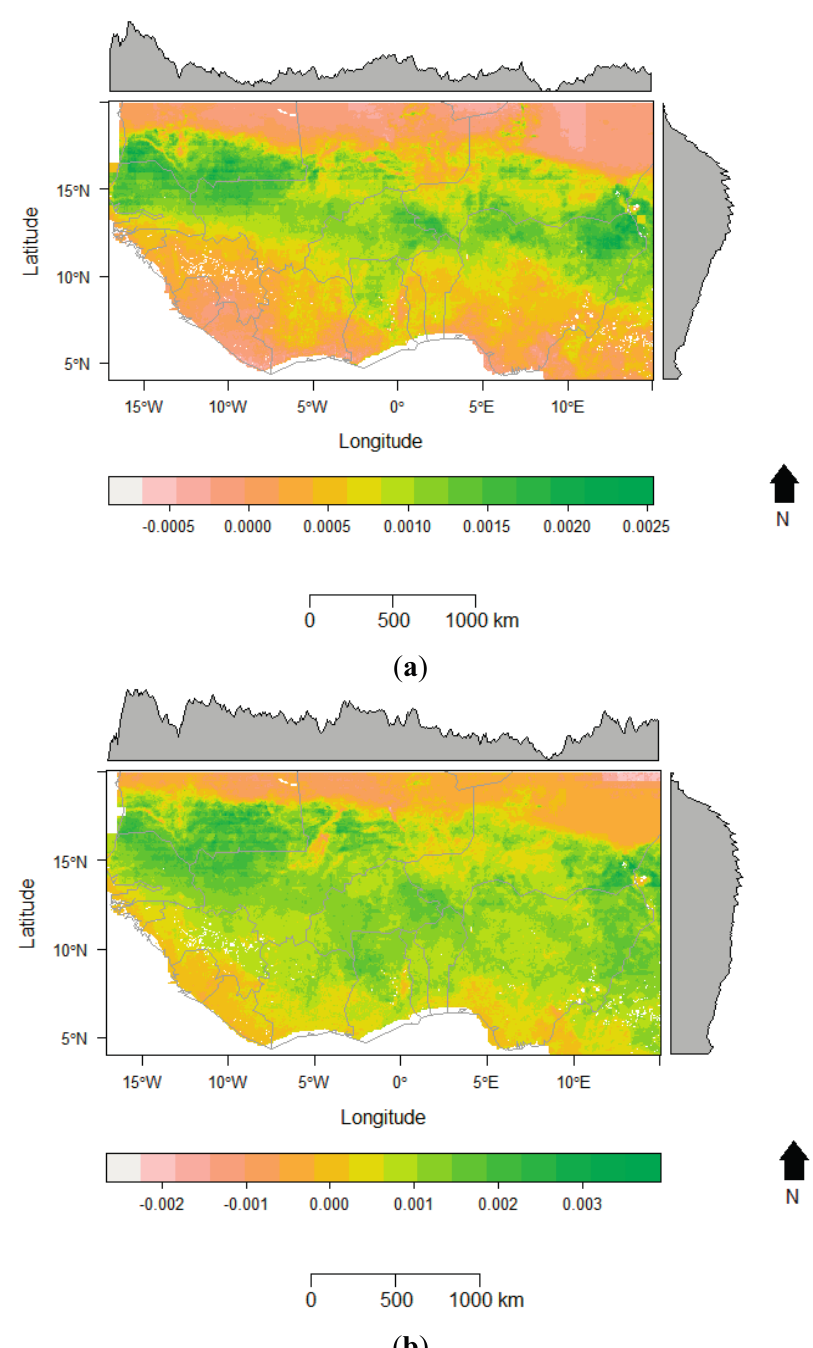
Figure 2. Spatial pattern of slope of the linear regression of Normalized Difference Vegetation Index (NDVI) against ( a ) soil moisture and ( b )